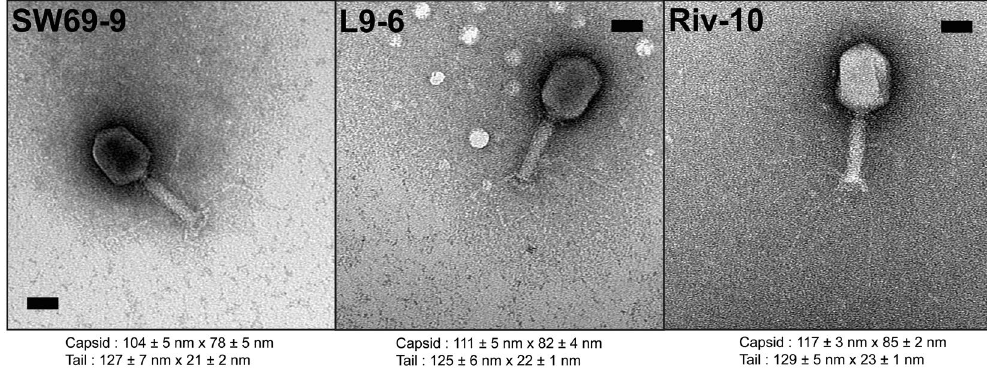
Figure 1. Micrographs of phages SW69-9, L9-6 and Riv-10. The average head/tail length and diameter are indicated below each phage. The bars represent 50